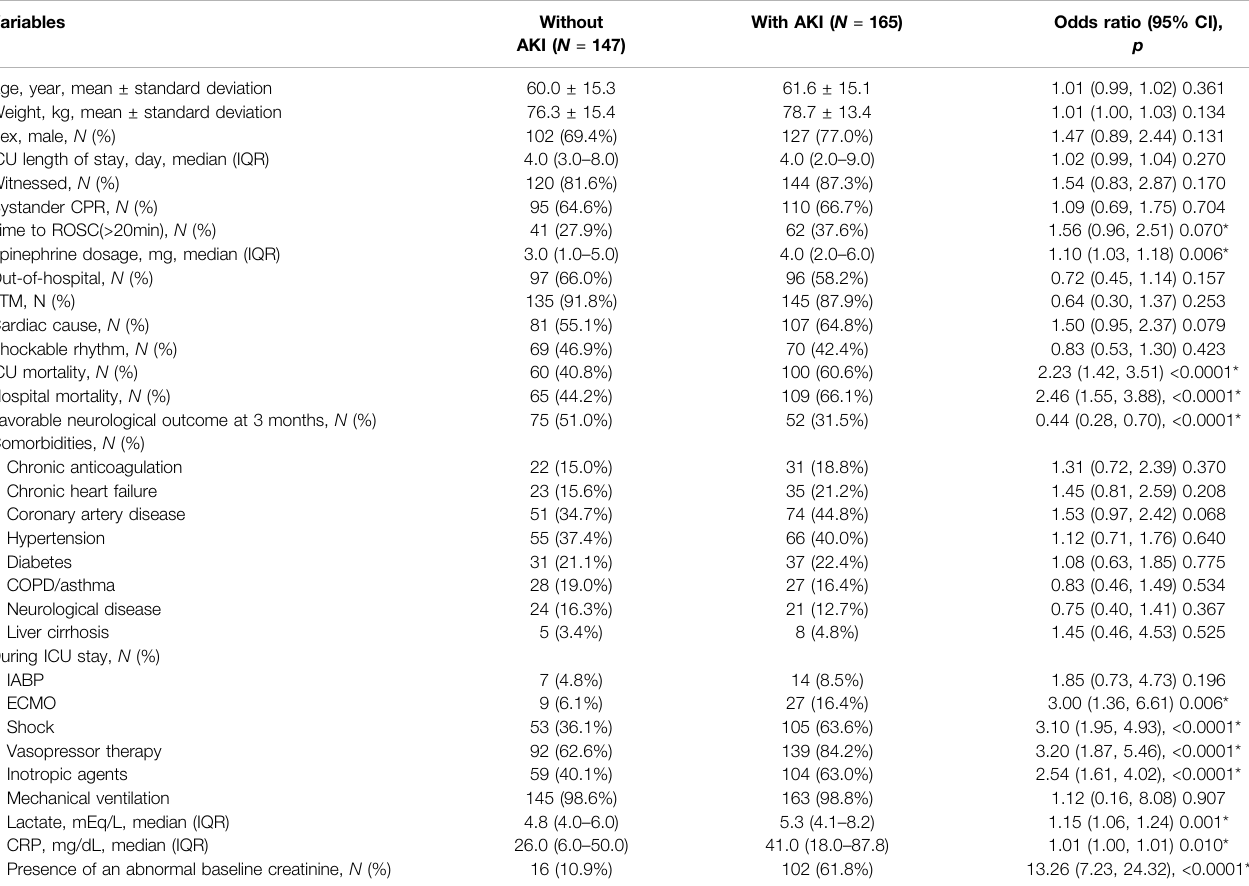
TABLE 2 | Bivariate analysis of associations between different variables and AKI. Variables